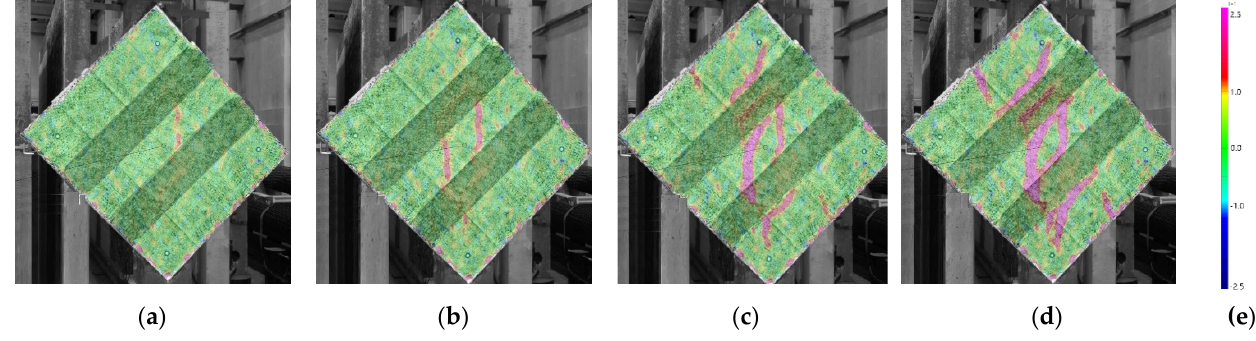
Figure 12. The process of strain growth in strengthened wall of Y-CFRP-a series: ( a ) deformations at force causing destruction of the Y-US series wall; ( b ) diagonal character of deformation; ( c ) beginning of CFRP delamination; ( d ) deformation just before failure; ( e ) deformation scaleIn walls strengthened with CFRP sheets (both configurations), the location of the composite detachment was arbitrary and did not depend on the location of unfilled joints. The relatively stiff CFRP composite effectively integrated the wall, preventing the joints from deformation. This ensured uniform masonry operations and relatively high safety of use.